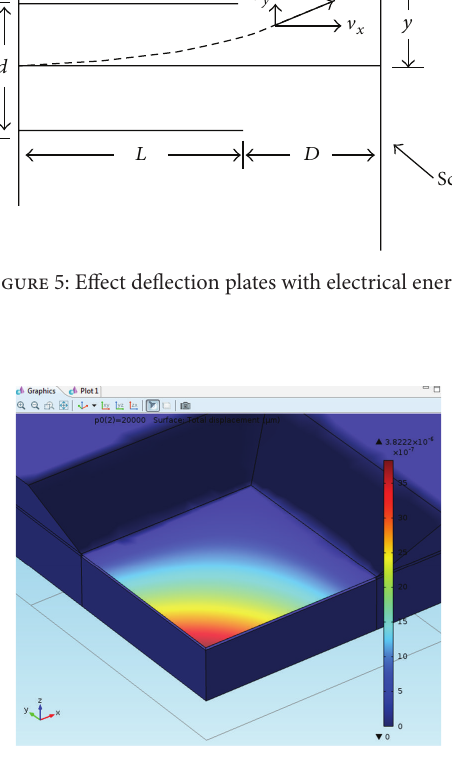
Figure 6: Structure surface deflection of diaphragm with applied pressure.